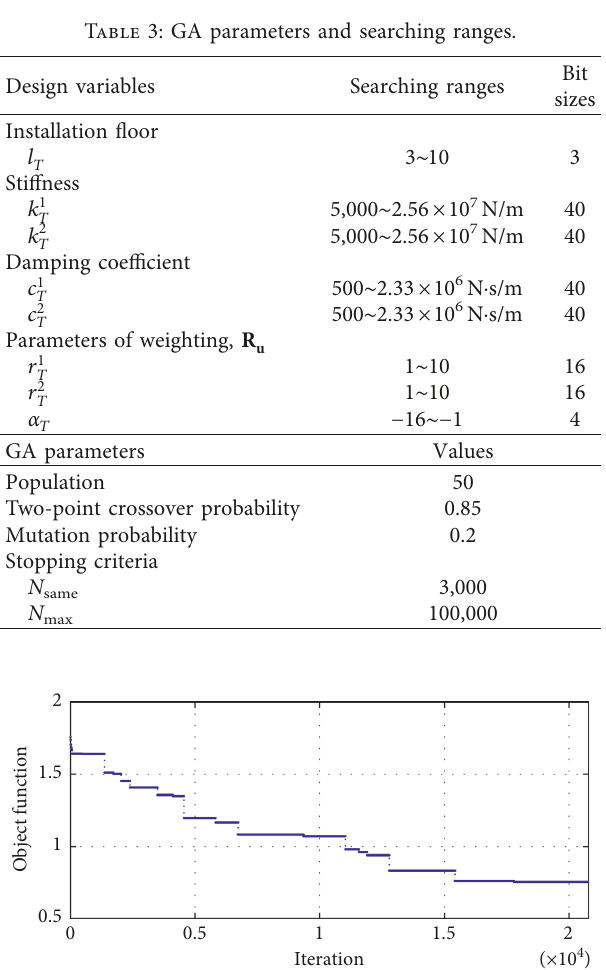
Figure 2: Convergence curve of objective function in GA opti- mization process.